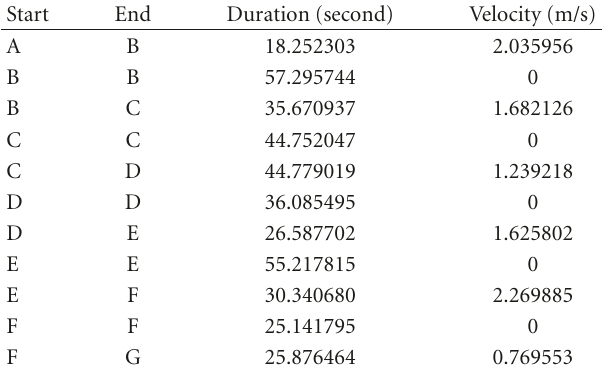
Figure 16: Variation in DIF value obtained by the MT in WLAN. Table 3: Parameters of user motion in WLAN.